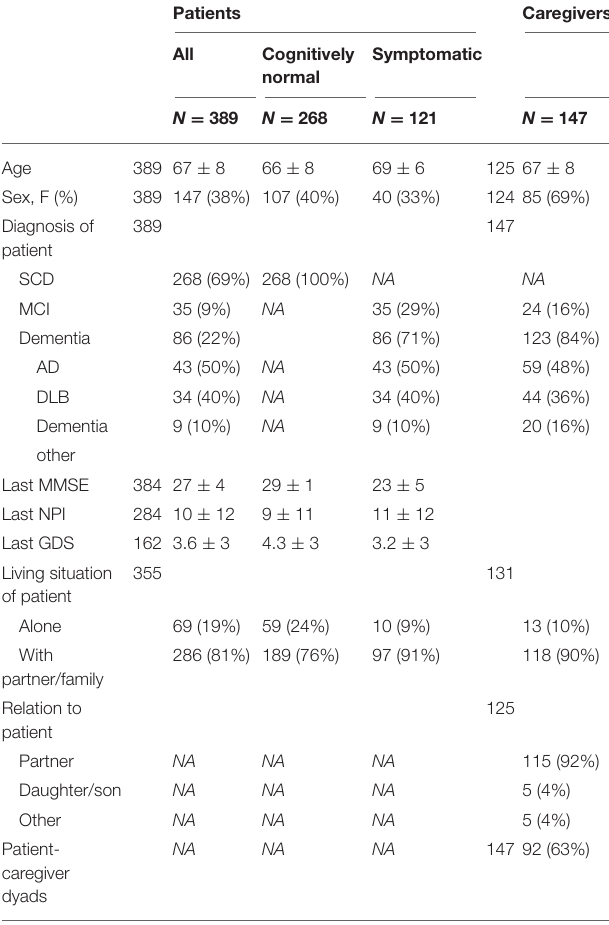
TABLE 1 | Patient and caregiver